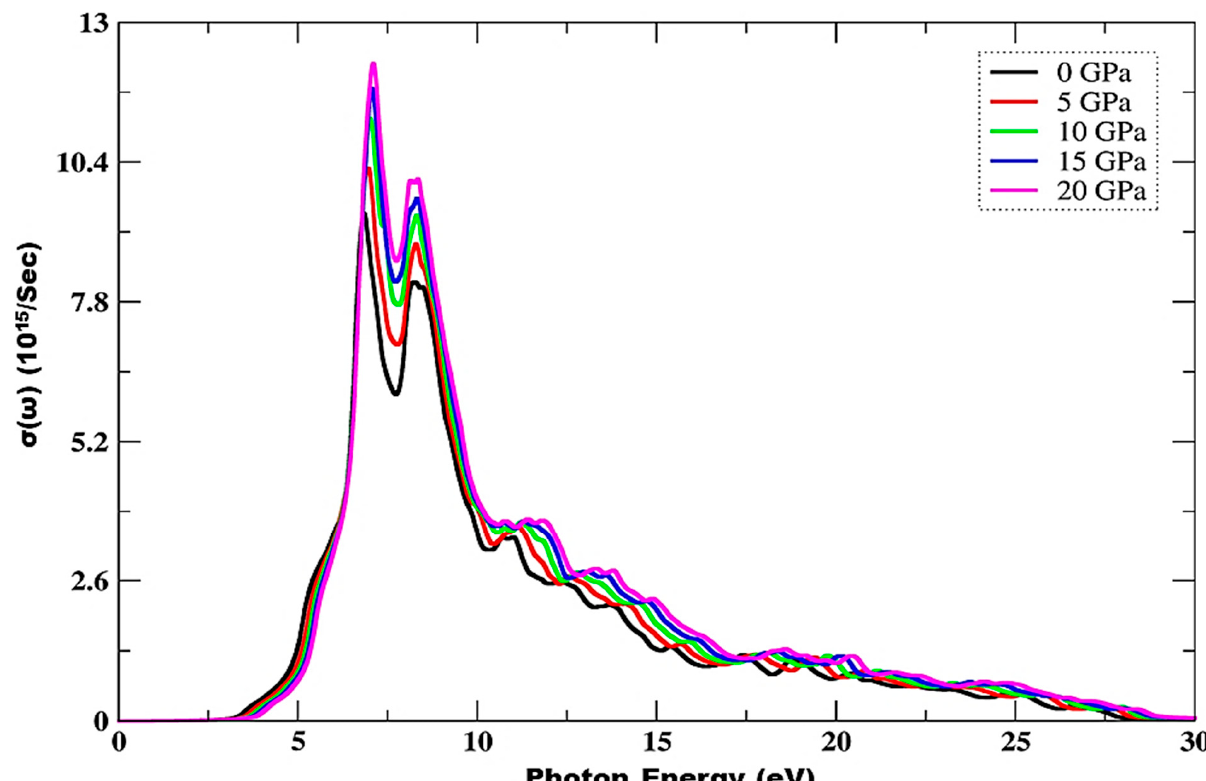
Figure 8. Pressure-influenced variations in optical conductance.